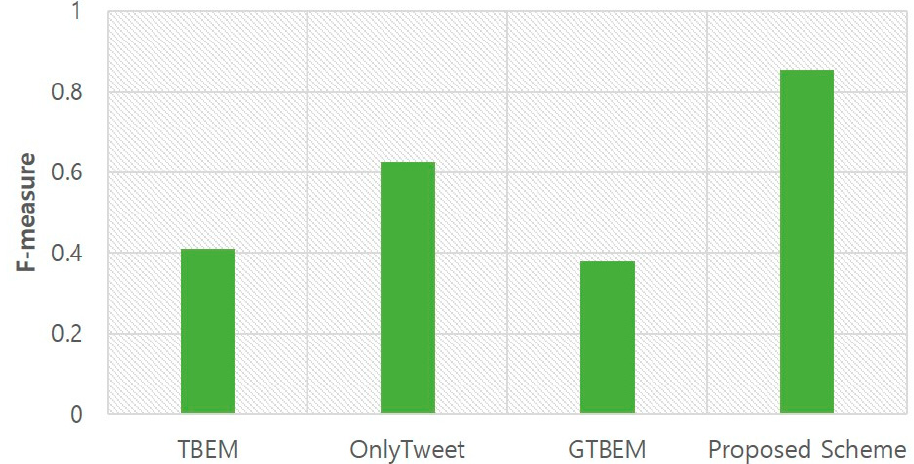
Figure 10. Comparison of F-measure according to the local event detection schemes.